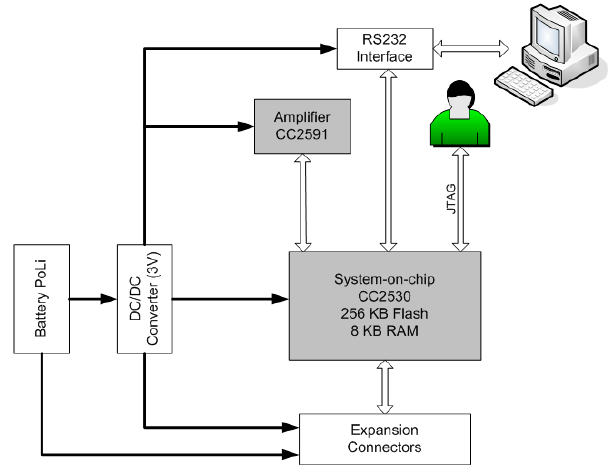
Figure 2. Block diagram of the mainboard.